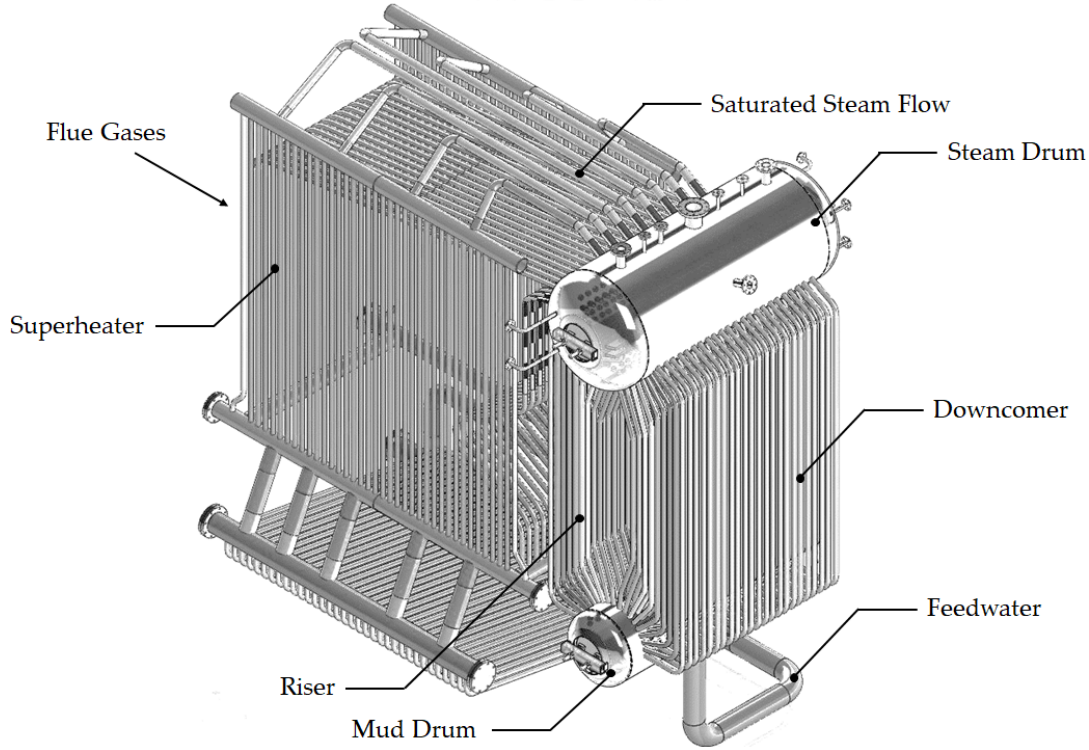
Figure 2. A 3D model of a typical drum boiler configuration. mGA, micro genetic optimization algorithm.